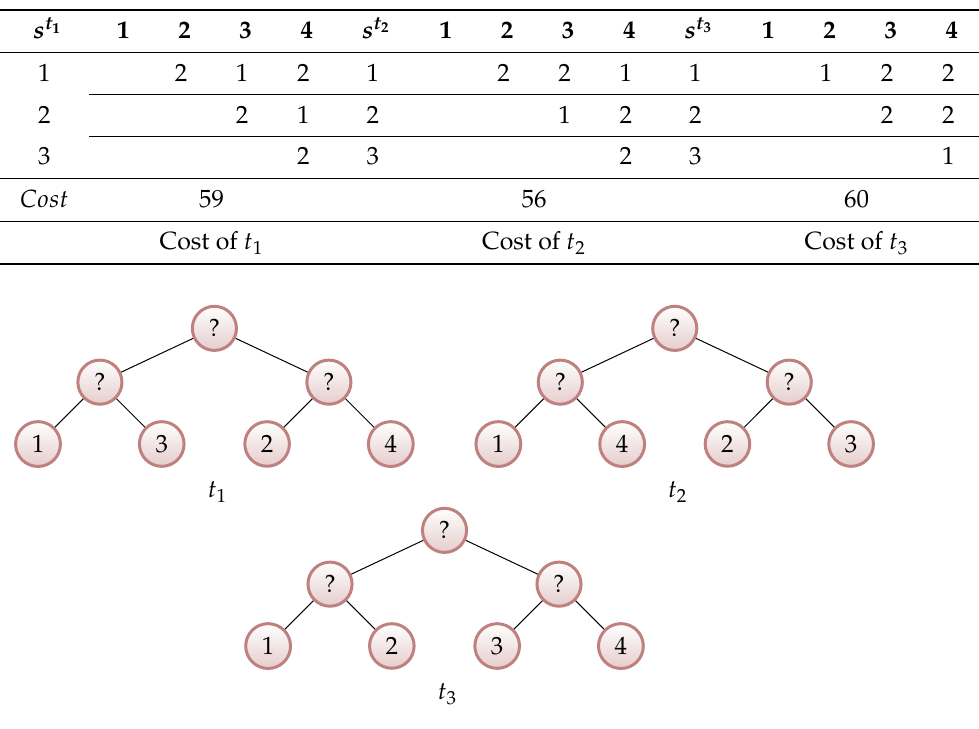
Figure 4. Balanced tournaments with four